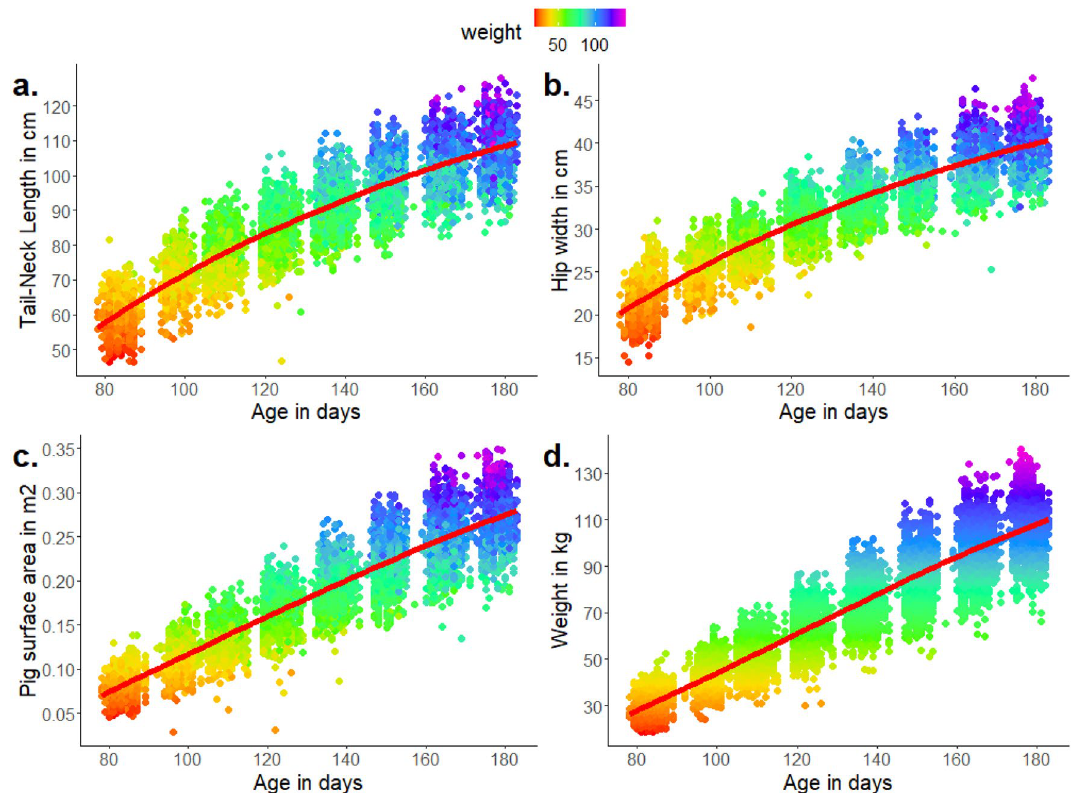
Figure 4. Evolution of body dimensions in function of age (in days) and colored by weight (in kg). A smoothed regression line is shown in red. Per pig, a maximum of eight recordings took place every fourteen days, explaining the eight separate data ‘blocks’ with whitespaces in between. ( a ) Evolution of tail-neck distance. ( b ) Evolution of hip width. ( c ) Evolution of pig surface area. ( d ) Evolution of weight. The graph for shoulder width is not shown, as it was equivalent to hip width.